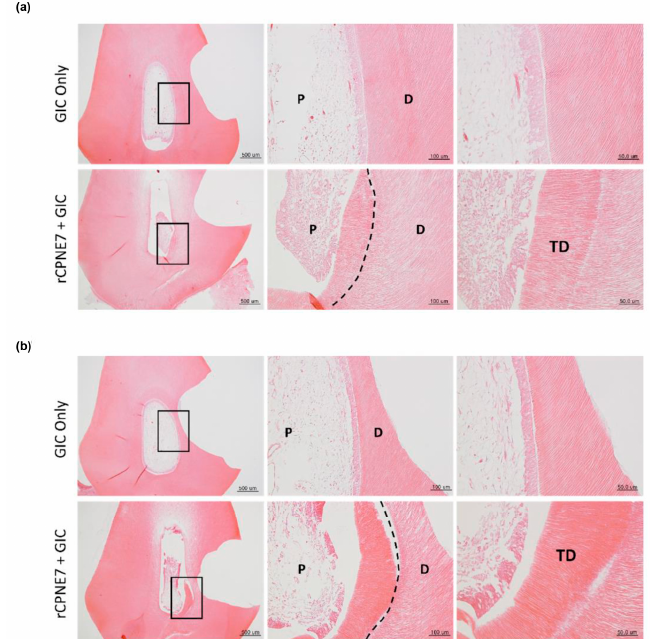
Figure A1. Histological analysis six weeks after the in vivo treatment of rCPNE7. ( a ) Histological analysis of dental pulp responses at the shallow cavity preparation areas treated with or without rCPNE7 after six weeks by hematoxylin and eosin staining ( n = 6). Dashed line indicates the remaining original dentin/newly formed dentin interfaces. ( b ) Histological analysis of dental pulp responses at the deep cavity preparation areas treated with or without rCPNE7 after 6 weeks by hematoxylin and eosin staining ( n = 6). Dashed line indicates the remaining original dentin/newly formed dentin interfaces. Materials 2020 , 13 , x FOR PEER REVIEW